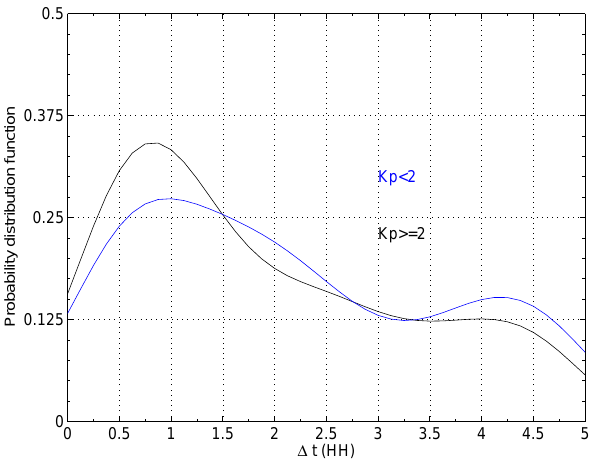
Fig. 8. The probability distribution of the time difference between SAPS and substorm onset for two different levels of geomagnetic activity, Kp ≥ 2 (black) and Kp < 2 (blue).